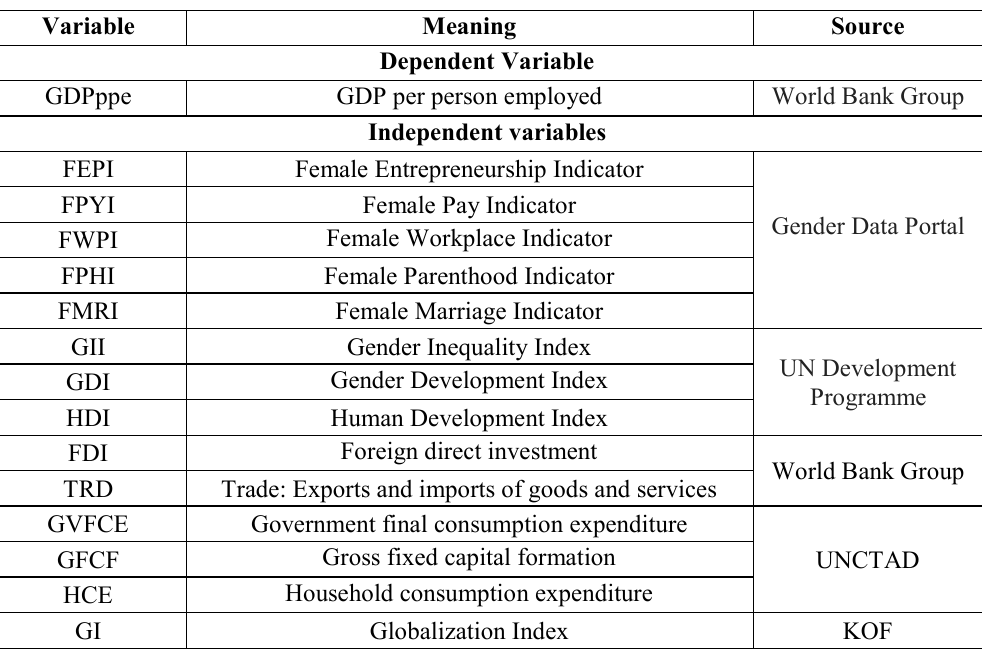
Table 1. Description of